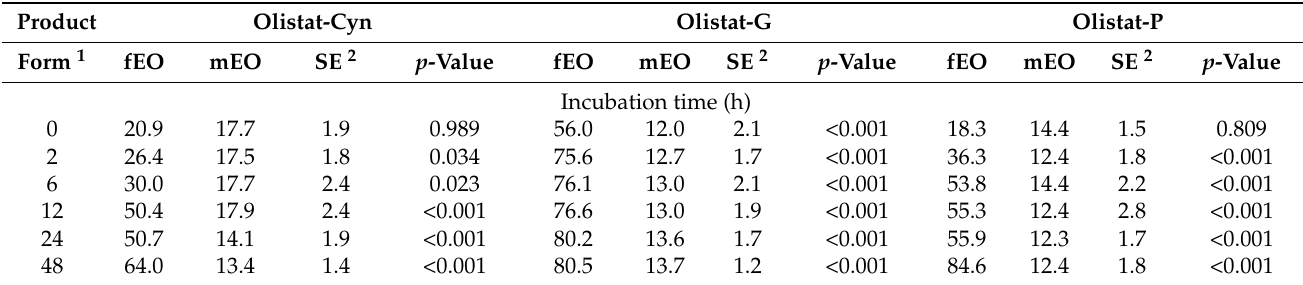
Table 1. LS means of the in vitro dry matter disappearance (DMD, % DM) of the essential oil products, free (fEO) or microencapsulated (mEO), after